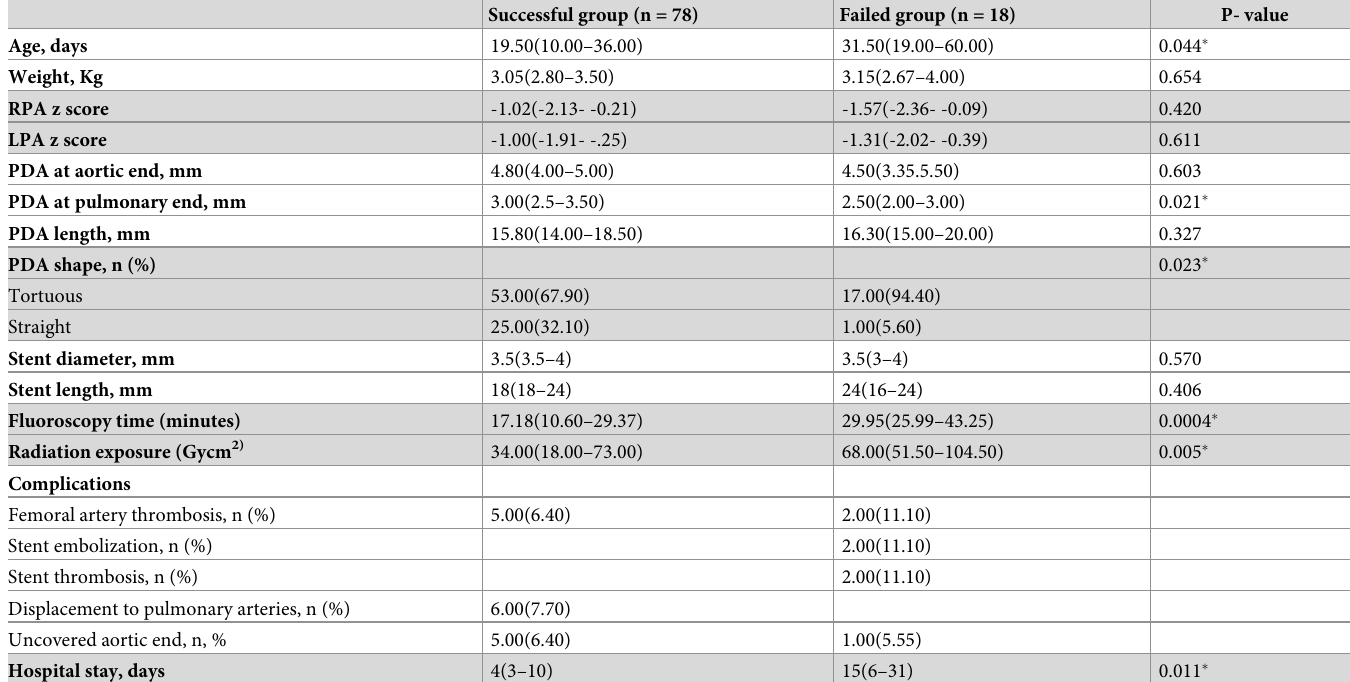
Table 2. Comparison between groups with successful and the failed procedures.